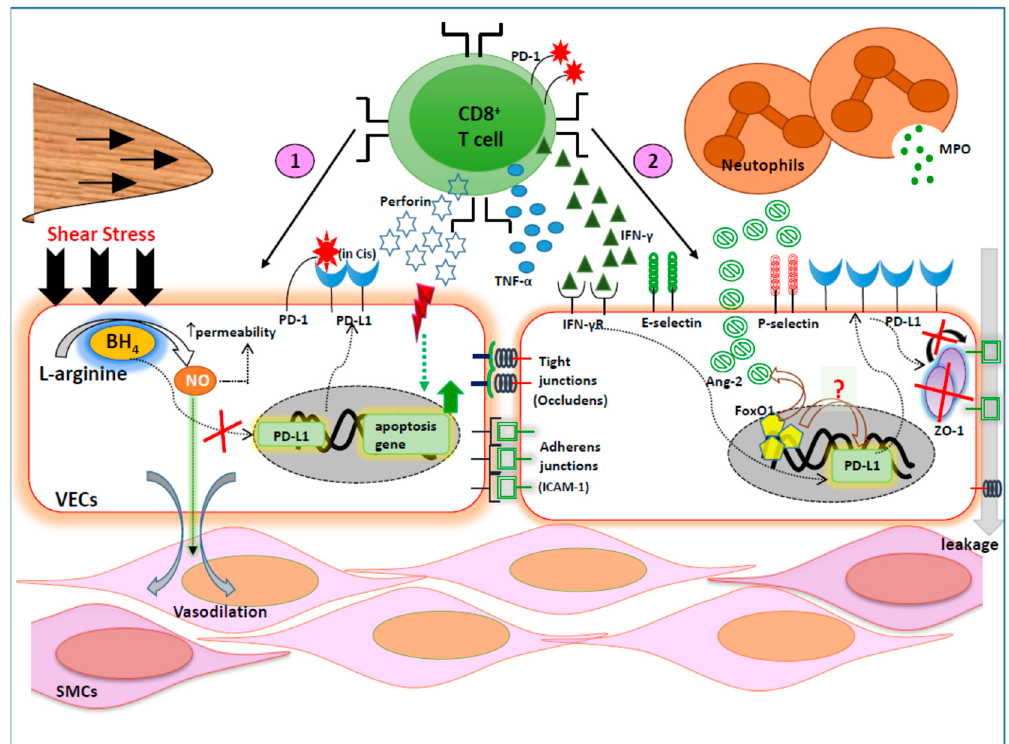
Figure 1. Role of PD ‐ L1 on vascular endothelial cell injury and barrier functions. Regulation of blood vessel inflammation by PD ‐ L1/PD ‐ 1 axis. An increased shear stress causes vascular endothelial cells (VECs) to produce nitric oxide (NO) from L ‐ arginine in the presences of one of the several nitric oxide synthase (eNOS) cofactors, such as tetrahydrobiopterin (BH4). The generation of NO leads to vasodilation of smooth muscle cells (SMCs) and increases the VECs’ permeability. The cofactor, BH4, prohibits the PD ‐ L1 gene transcription and reduces the expression of PD ‐ L1 proteins on VECs. (1) Minimally expressed PD ‐ L1 molecules have a higher possibility of binding to PD ‐ 1 molecules in cis, expressed on VECs. Diminished expression of PD ‐ L1 boost the aggressiveness of pro ‐ atherogenic CD8 + T cells, leading to VEC injury via cytolytic enzymes such as perforin and pro ‐ inflammatory cytokines, TNF ‐α and IFN ‐γ . This insult to the VECs results in the expression of pro ‐ apoptotic genes and enhances VEC apoptosis. (2) The released IFN ‐γ from CD8 + T cells binds to IFN ‐γ receptors and further induces PD ‐ L1 protein expression on VEC surfaces. Increased PD ‐ L1 hampers zonula occludens ‐ 1 (ZO ‐ 1), which regulates the expression of tight junctional molecules. PD ‐ L1 ‐ mediated ZO ‐ 1 dysregulation shatters the junctional proteins, which breaches the VEC barrier causing leakage.